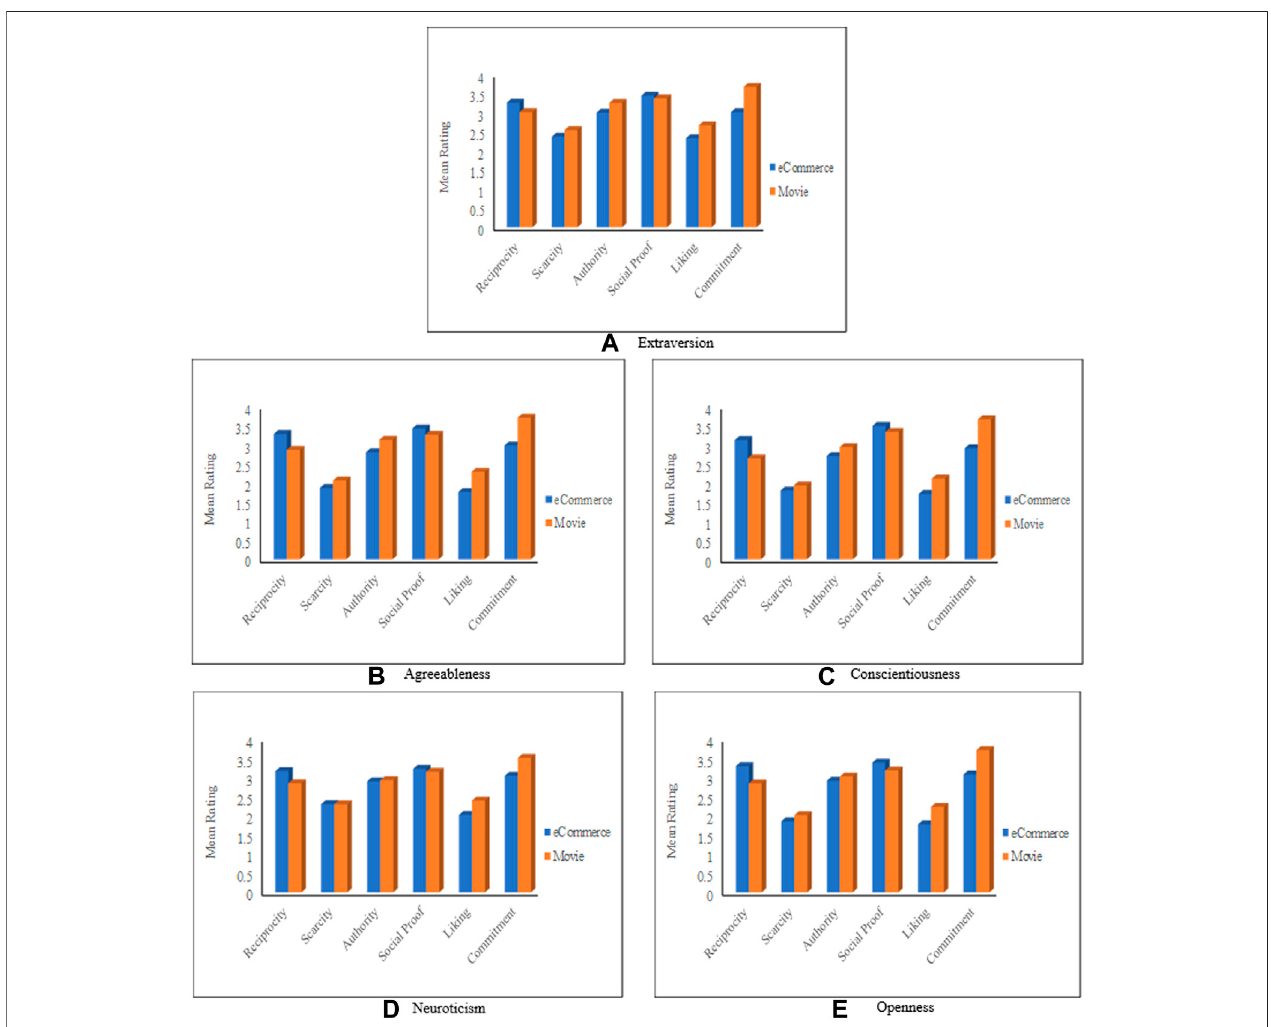
FIGURE10| Meanratingbasedonthepersonalitytraitsandtheapplicationdomain. (A) Extraversion, (B) Agreeableness, (C) Conscientiousness, (D) Neuroticism, (E) Openness.